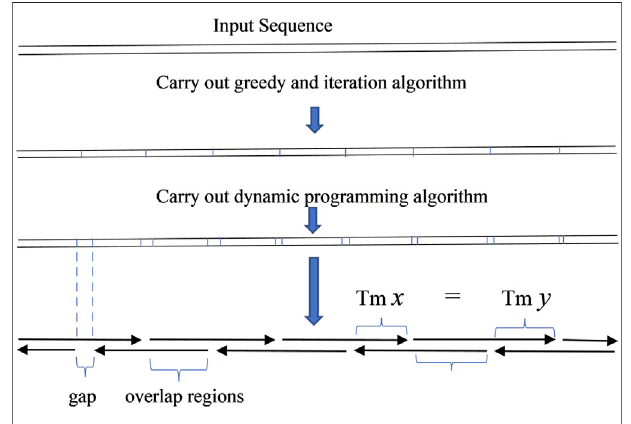
FIGURE 2 | Scheme of gapped PCR assembly.